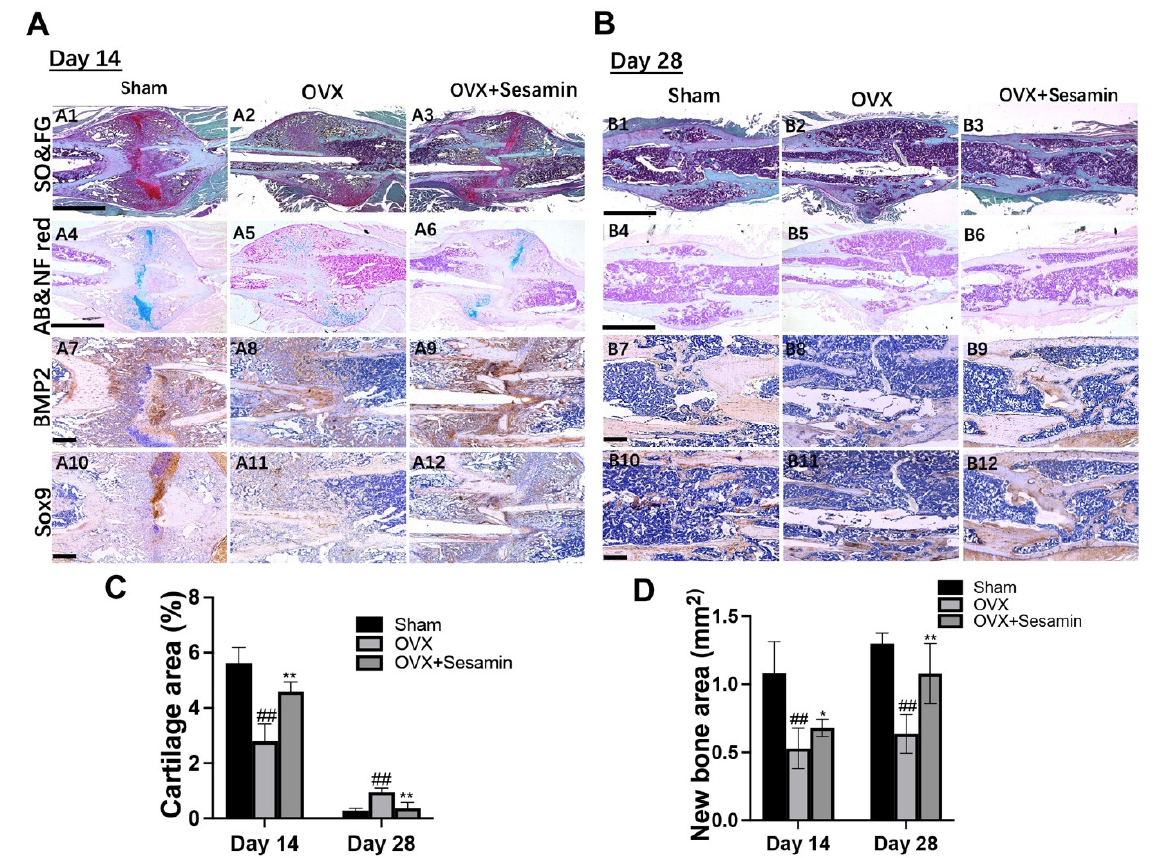
Figure 5. Histological analysis of osteoporosis fracture healing upon sesamin treatment in vivo. ( A , B ) Safranin O/fast green (SO and FG) and alcian blue/nuclear fast red (AB/NF red) staining of femur fracture sites 14 (A1–A6) and 28 days (B1–B6) after surgery. IHC staining of femur fracture sites using BMP2 and SOX9 antibodies at day 14 (A7–A12) and day 28 (B7–B12) post-surgery. ( C ) Semi-quantitative analysis of cartilage area of each group at different timepoints after fracture. ( D ) Semi-quantitative analysis of newly formed sponge bone area in each group ( n = 6; ## p < 0.01 vs. Sham group; * p < 0.05, ** p < 0.01 vs. OVX group).